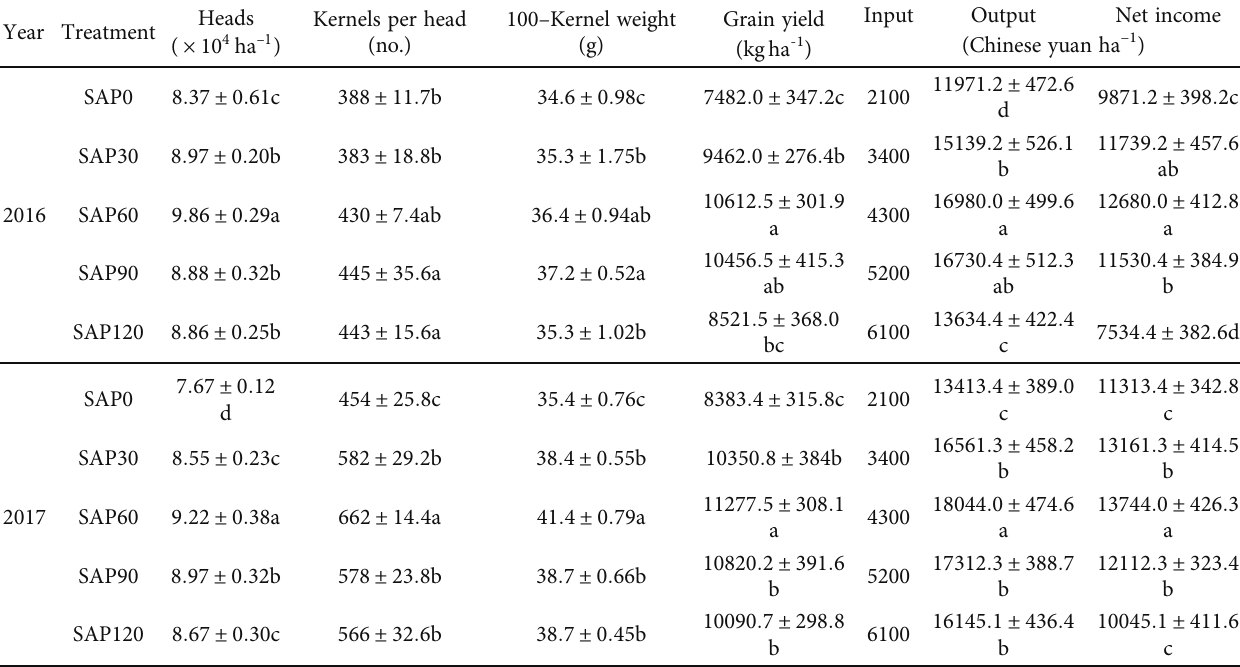
Table 4: Crop productivity and economic bene fi t of maize under multifunctional SAP